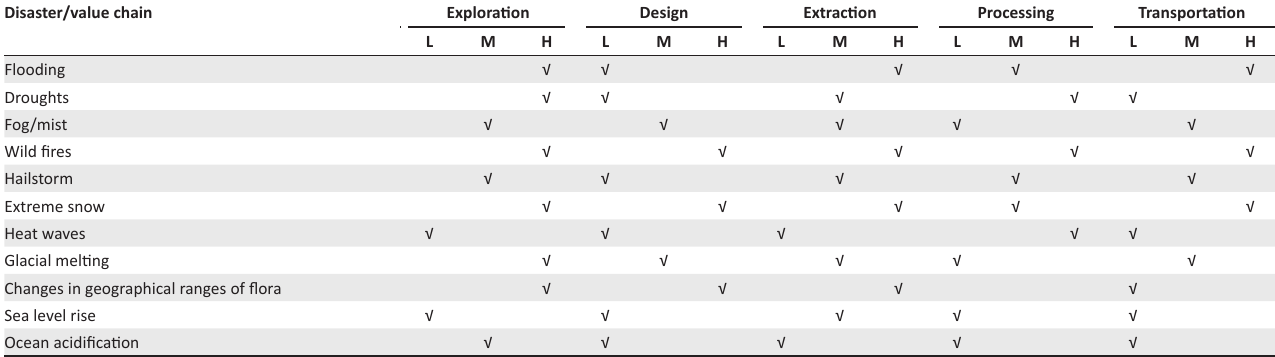
TABLE 1: Impact of climate change-induced events along stages of coal mining value chain. Disaster/value